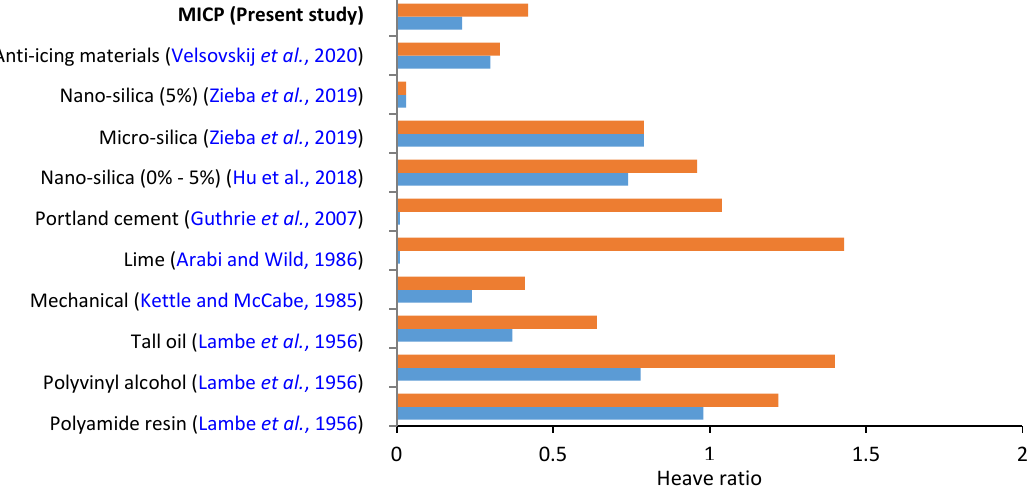
2Polyamide 0 0.5 1 1.5 Fig. 8: Comparison of the different methods for the mitigation of frost Fig. 8: Comparison of the different methods for the mitigation of frost heave